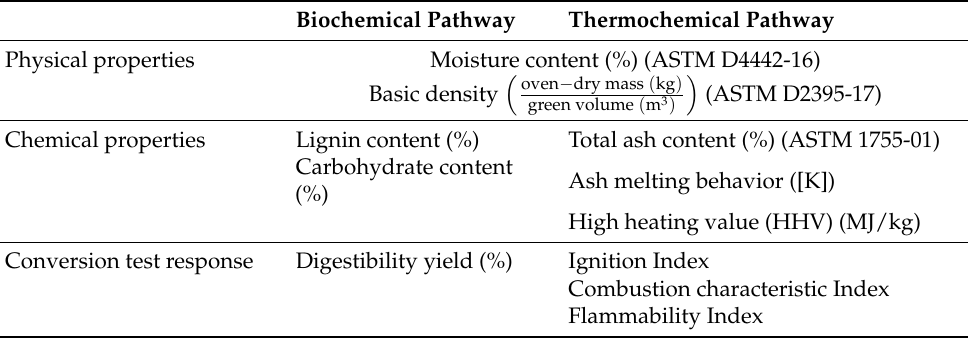
Table 2. Physical and chemical properties, and conversion test responses of interest according to conversion